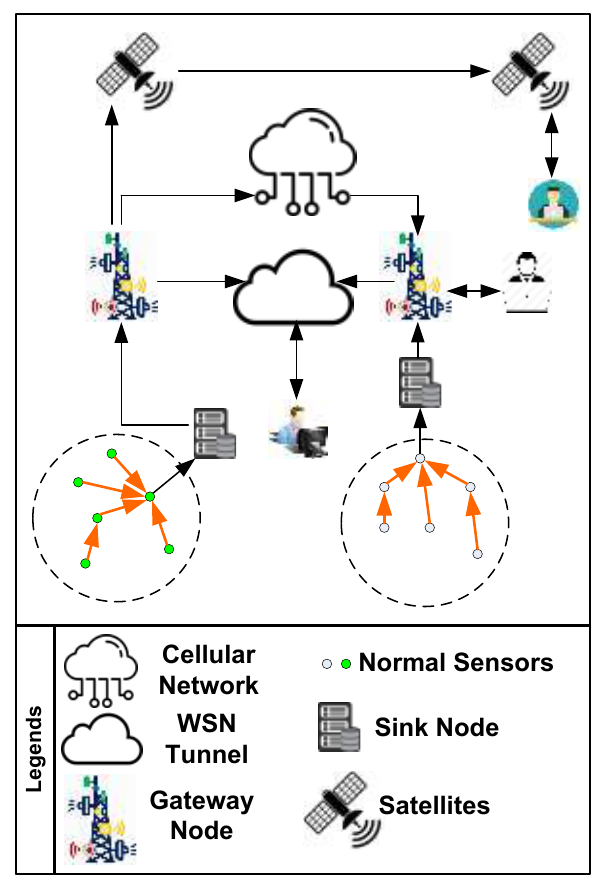
Figure 1. Adopted Case Study showing two heterogeneous sample groups of sensors connected via the sink node and gateway node to WSN tunnel and inter-satellite links. The proposed hybrid MAC scheme is used for both resource management and improving data transmission. The exchange of the slot information is carried out by communicating a cluster head via gateway